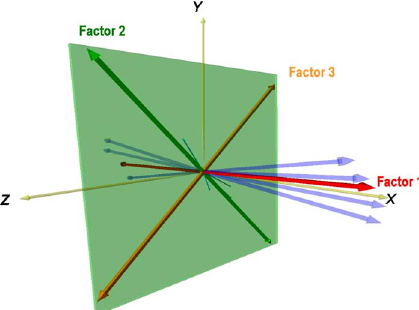
FIG. 3. (cid:1) Color (cid:2) Sum of the squared projections of the blue arrow onto the red arrow (cid:1) through the origin (cid:2) is maximized. The red arrow represents factor 1.